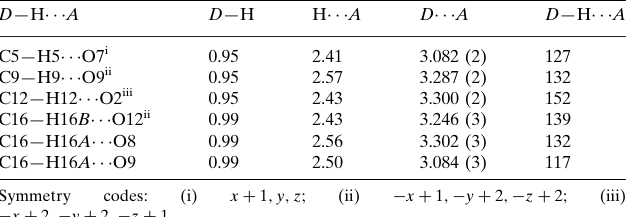
Hydrogen-bond geometry (A˚ , (cid:3) ).